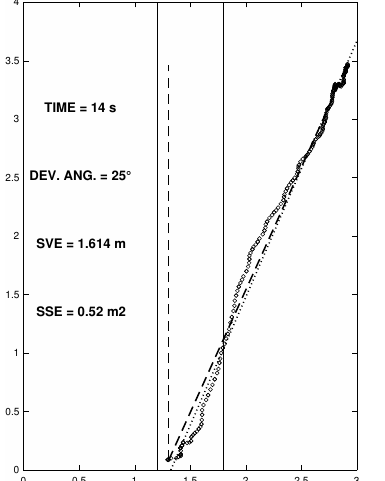
Figure 4. Participant A post-test veering path with small deviation angle, large SSE and negative veering error (from participant D and E) have incomplete data and consequently were considered not valid for analysis, while all the post-test files were admitted. Among some of the test files, authors were unable to analyze 6 trials (all the 3 files of participant C, one of participant B, D and E) due an unforeseen behavior of the subjects during the test (see Section 4.2 for more